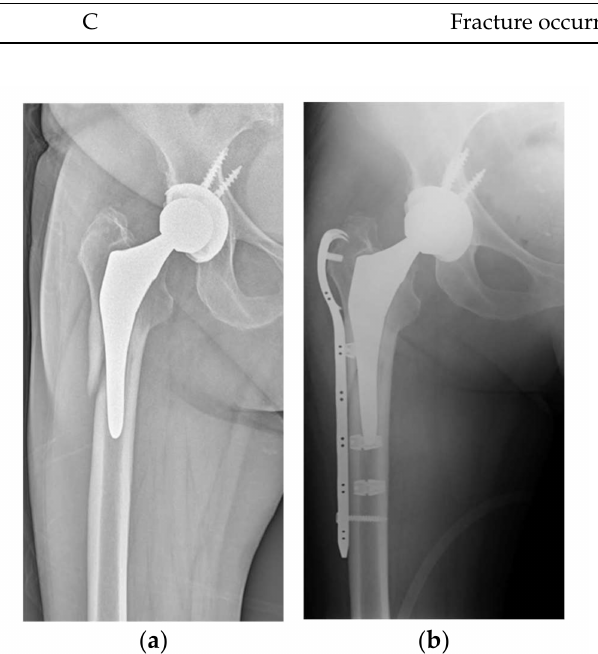
Figure 2. ( a ) Preoperative X-ray of type B1 fracture in 76-year-old patient; ( b ) postoperative 3-month follow-up after placement of a plate with UHMWPe